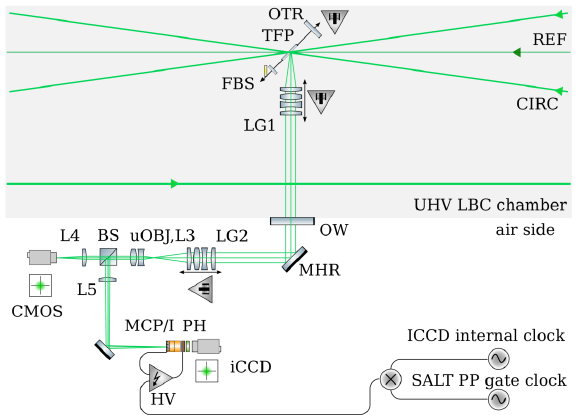
FIG. 16. Schematic of the IP imaging optical system. OTR: optical transition radiation target, TFP: thin film plate, FBS: fluorescent beam screen, LG1: Lens group objective 1, OW: optical window, MHR: mirror high reflectivity, LG2: lens group objective, uOBJ,L3: high magnification power micro objective, BS: beamsplitter, L4,L5: positive lens, MCP/I: micro channel plate/intensifier, PH: phosphor, ICCD: intensified CCD, HV: high voltage, CMOS: Complementary metal oxide semiconduc- tor area